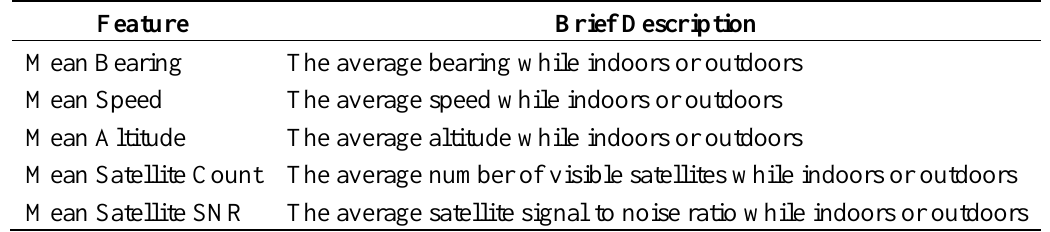
Table 2. Features computed from the smartphone’s GPS